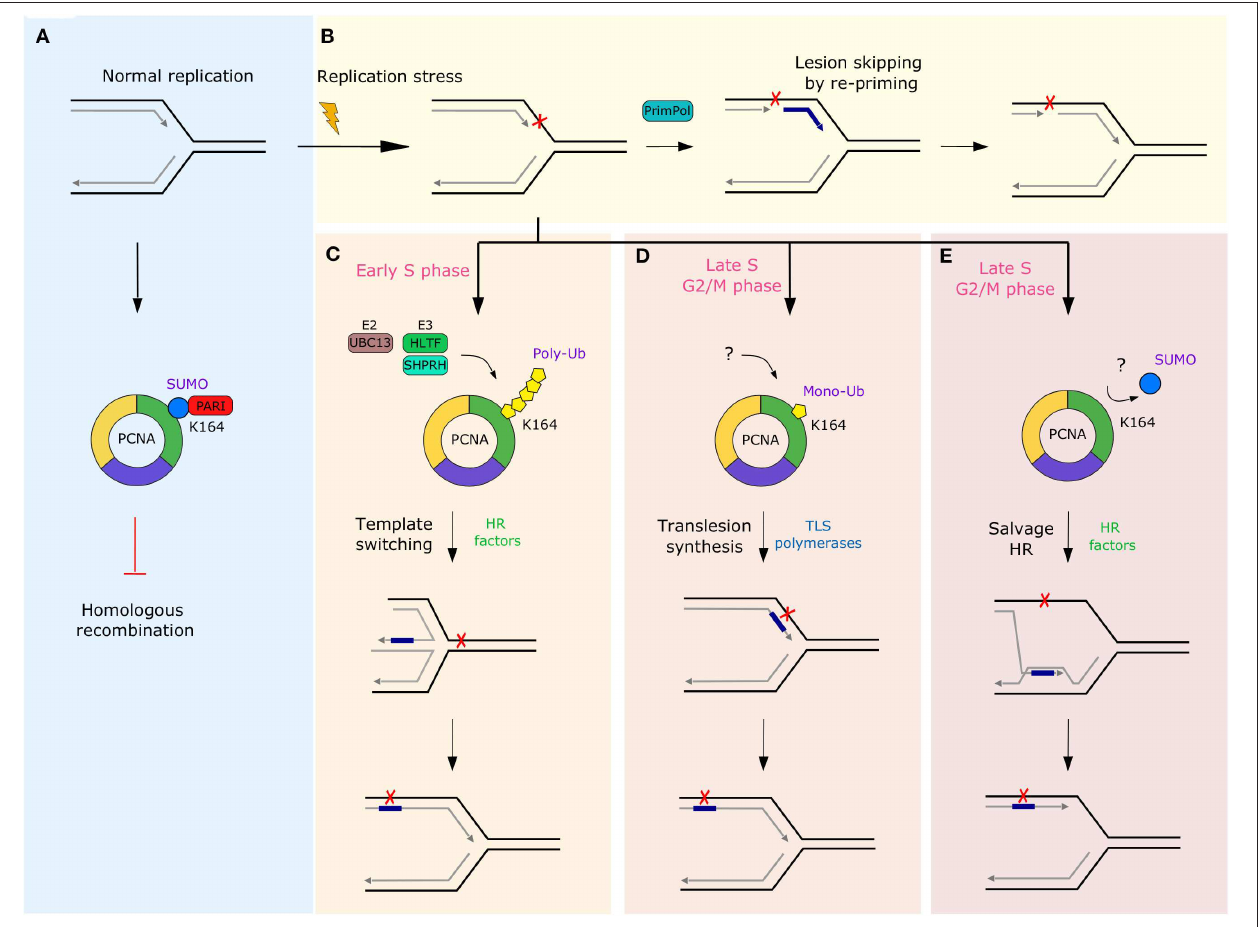
FIGURE 4 | Overview of the DDT pathways and their regulation by various post-translational modifications of PCNA. (A) During normal replication PCNA interacts with the anti-recombinase PARI through SUMO modification to prevent potentially mutagenic recombination events in the absence of replication stress. (B) In response to replication stress, PrimPol-mediated lesion skipping allows cells to re-initiate synthesis downstream of the lesion and prevent RF stalling, while leaving an ssDNA gap behind. Alternatively, cells can employ one of three DDT pathways regulated by various modifications at K164 of PCNA. (C) Poly-ubiquitination in early S-phase initiates a mechanistically complex, but error-free TS, which requires RAD51-mediated strand invasion and newly replicated sister chromatid for synthesis over the damaged template. In contrast, mono-ubiquitination leads to the frequently mutagenic TLS in late S or G2/M phase. This process requires a step-wise exchange of high-fidelity replicative polymerases for specialized low-fidelity non-processive polymerases to enable synthesis over the lesion (D) . (E) The last DDT mechanism is “salvage” HR repair which is commonly repressed by SUMOylation of PCNA and by the anti-recombinase PARI in order to prevent chromosome rearrangements caused by hyper-recombination. The question marks indicate that the factors involved in the processes in human cells are not clearly defined. HR, homologous recombination; PARI, PCNA-associated recombination inhibitor; SUMO, small ubiquitin-like modifier; TLS, translesion synthesis; Ub,